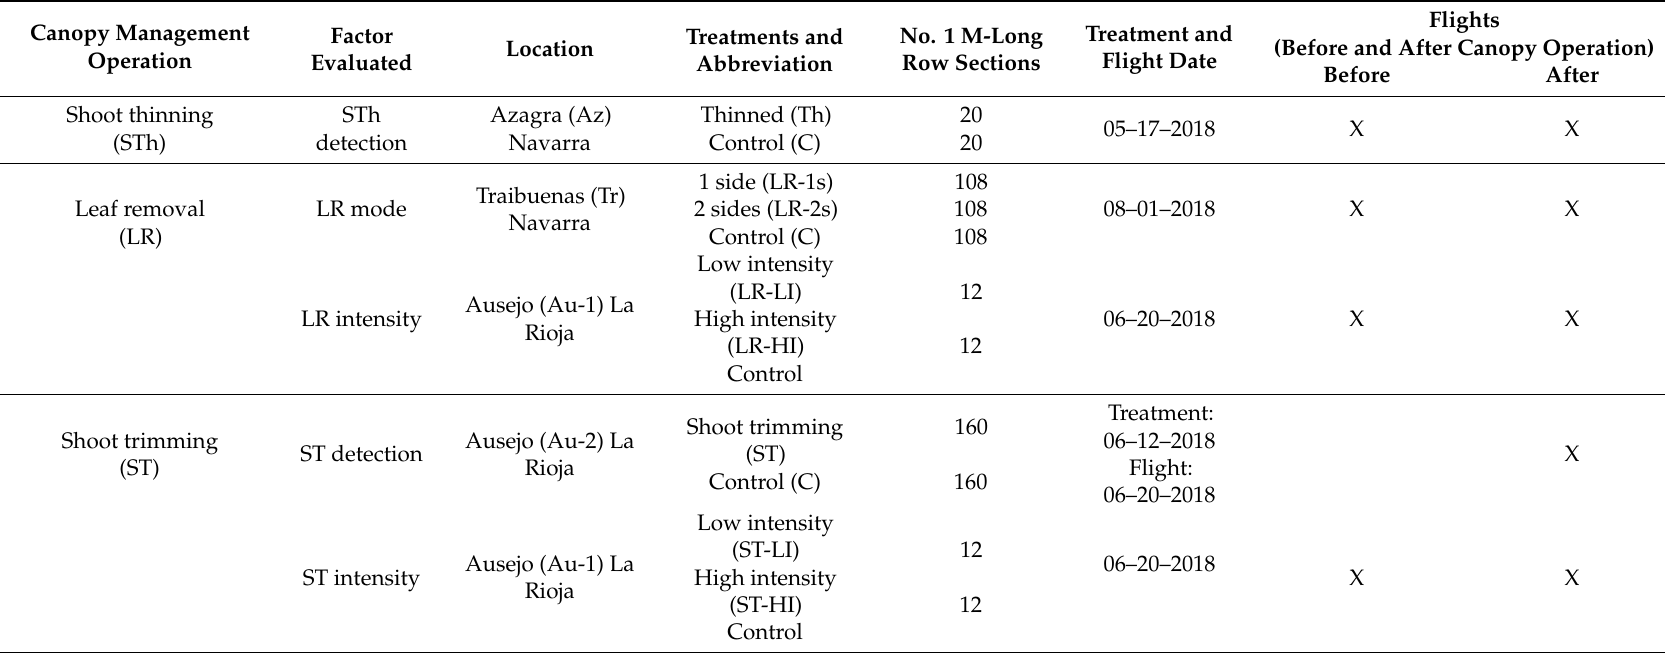
Table 2. Information about locations, canopy management operations, and UAV flights performed at the study